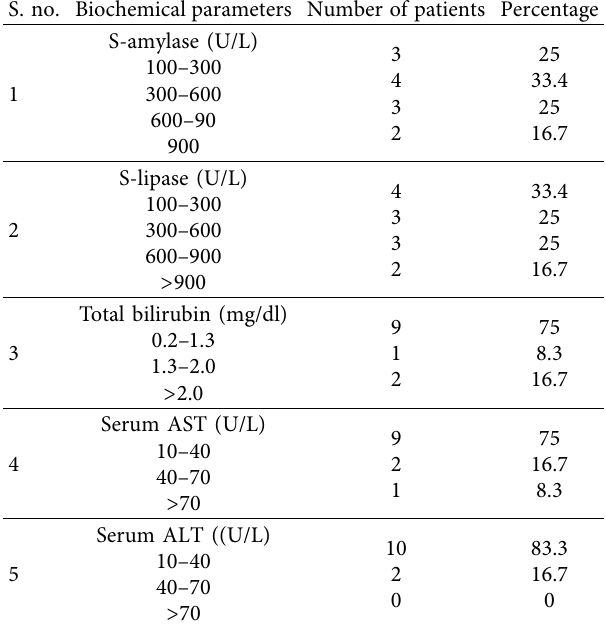
Table 1: Demographic and obstetric profile of the patients.